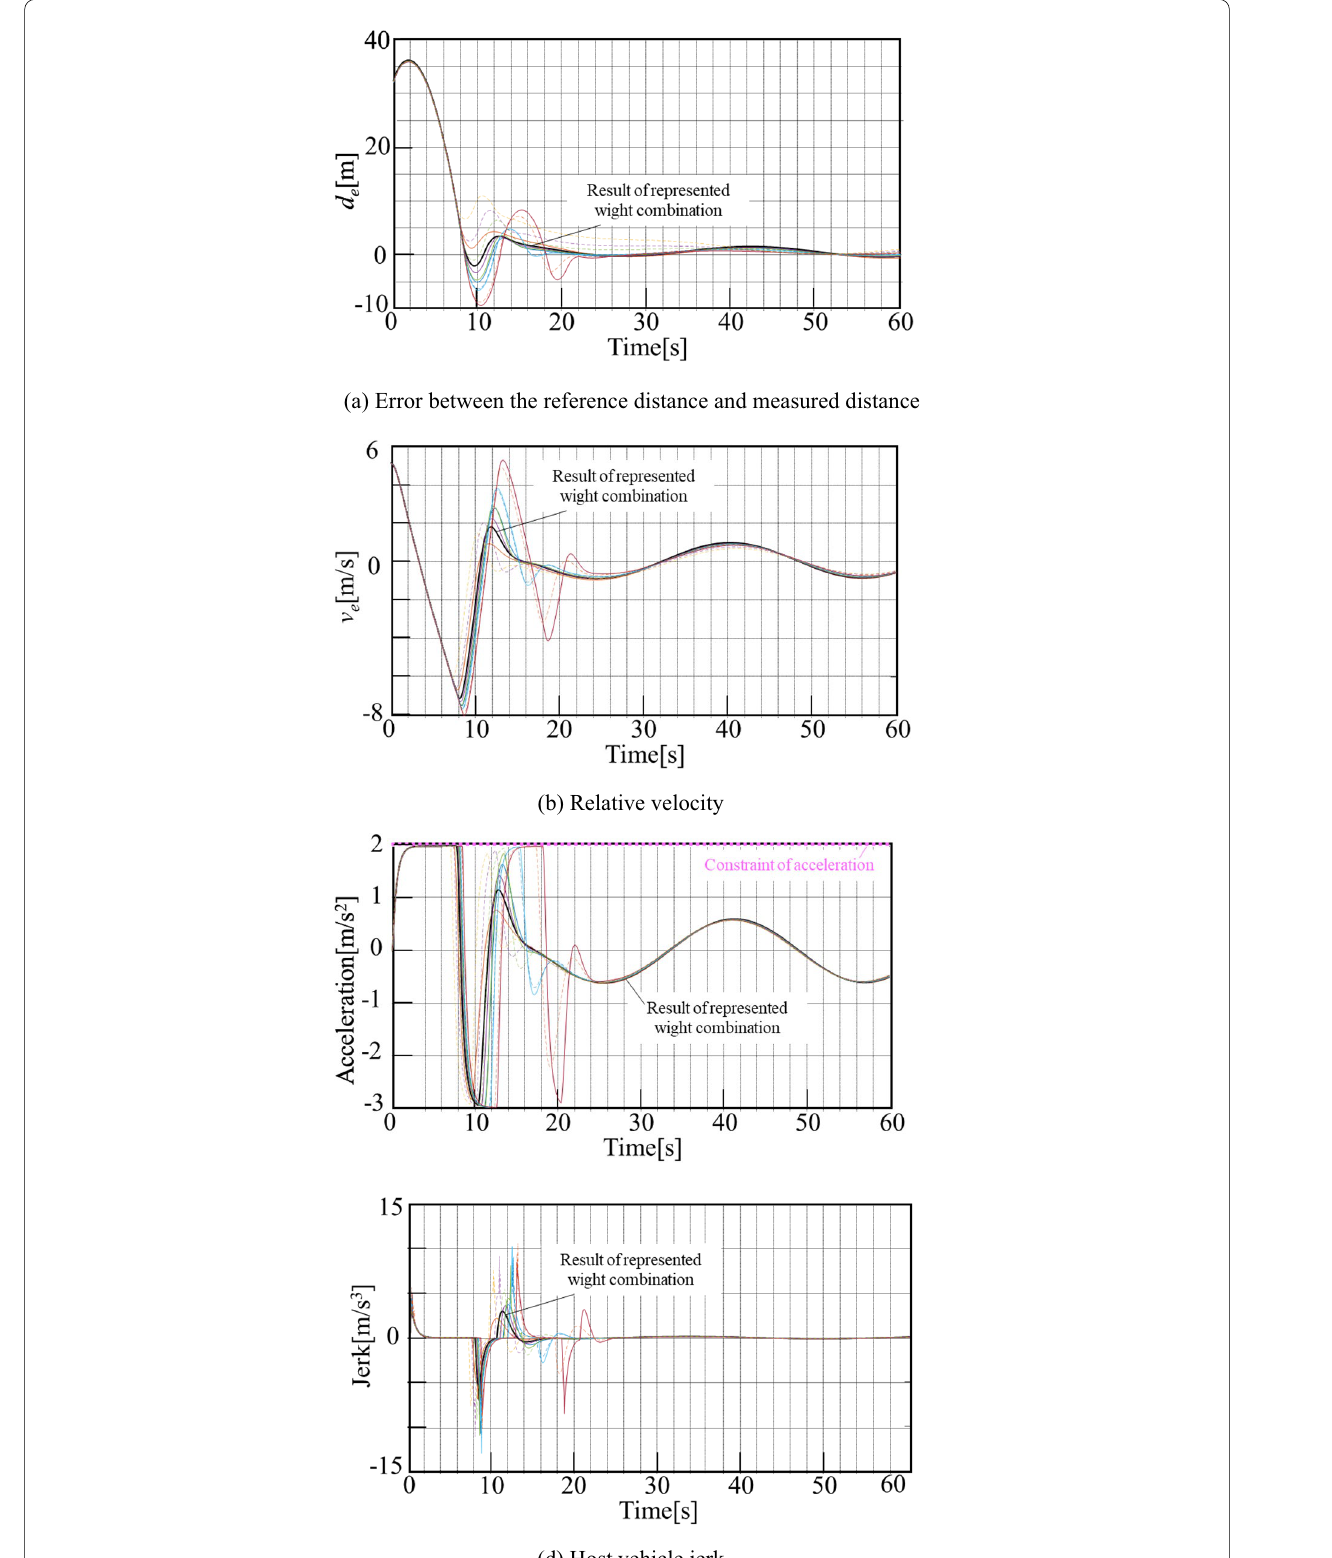
Fig. 7 (See legend on previous